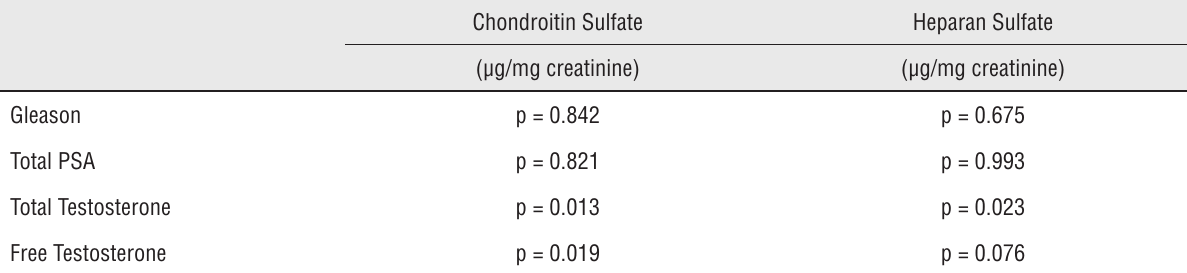
Table 3 - Evaluation of Gleason, PSA and the level of testosterone with the amount of sulfated